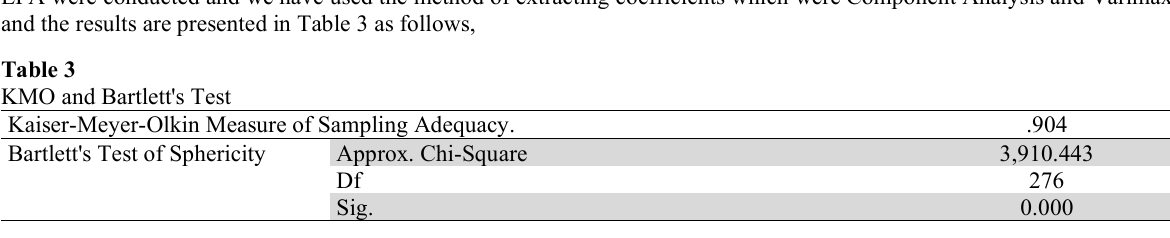
Results of analysis of Determinants Confidence of Scales in the Model Determinants n Cronbach’s Alpha Corrected Item-Total Accounting student factor (ASPF) 7 0.862